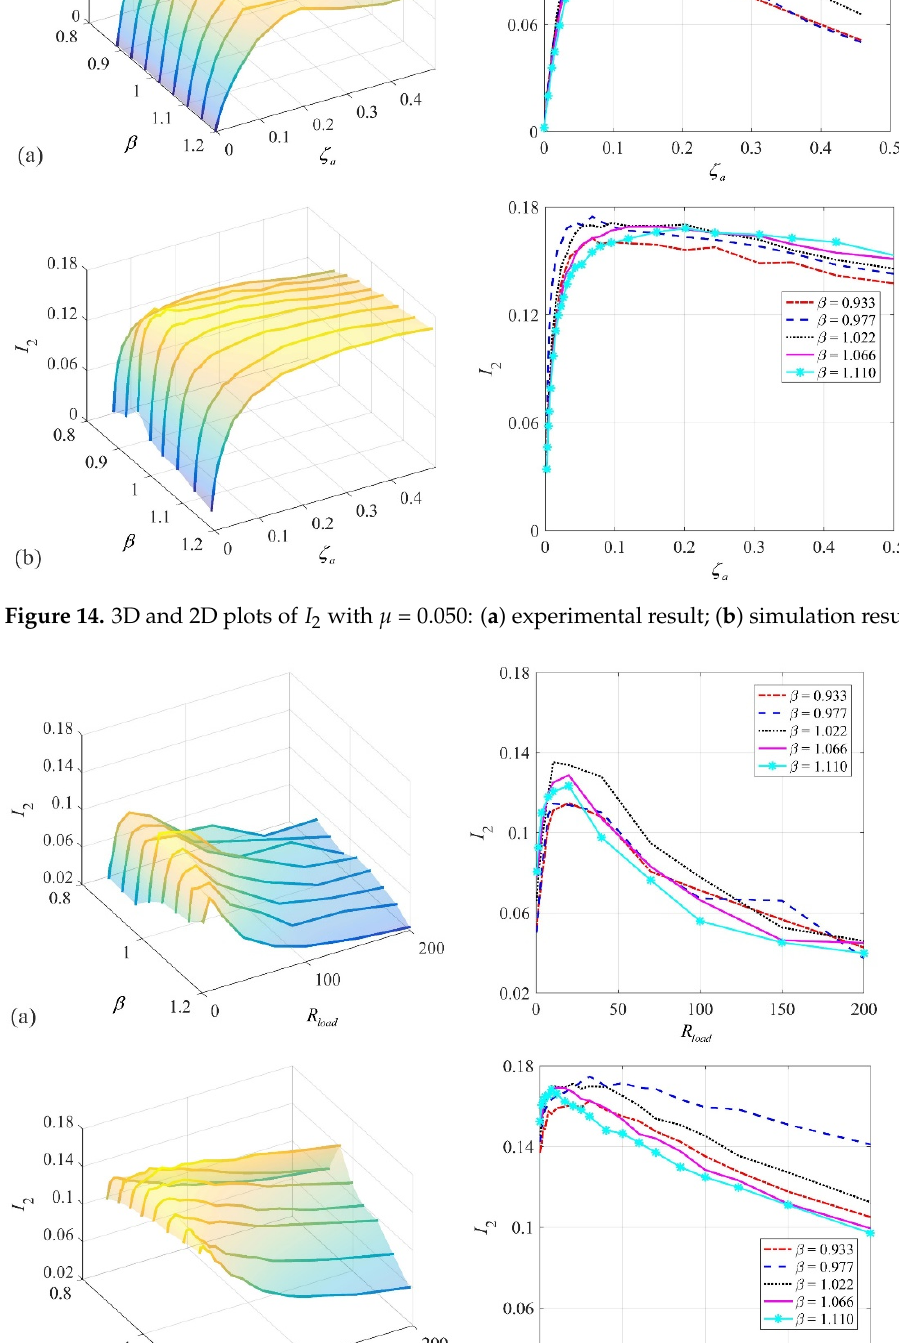
Figure 15. 3D and 2D plots of I 2 with µ = 0.050: ( a ) experimental result; ( b ) simulation result.